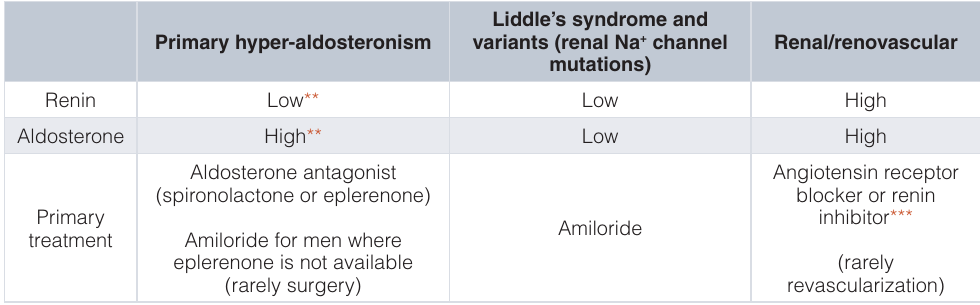
Table 1. Physiologically individualized therapy* based on renin/aldosterone